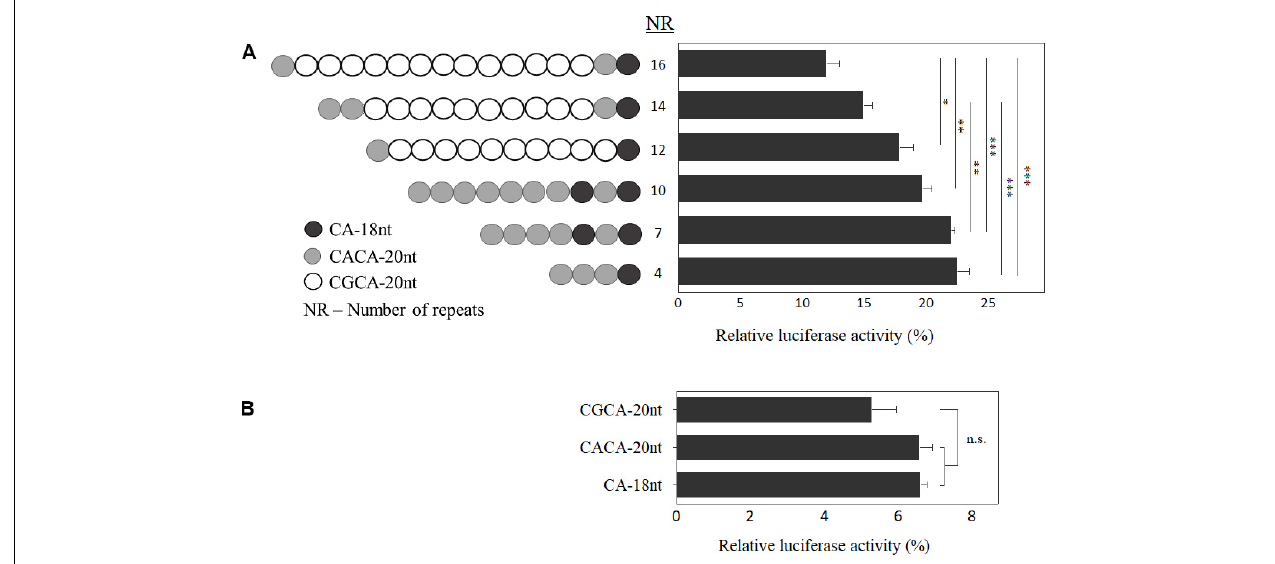
FIGURE 3 | Functional analysis of EIF4A3 5 (cid:48) UTR motifs. Graph depicting the relative luciferase activity, in percentage, of the constructs carrying different number of motifs (A) and of each motif independently (B) . Data are represented as mean ± SEM of five experiments, which were performed in triplicate. Relative luciferase activity = [(experimental sample ratio) – (negative control ratio)/(positive control ratio) – (negative control ratio)]. ∗∗∗ p < 0.001, ∗∗ p < 0.01, ∗ p < 0.05 and ns, non-significant; one-way ANOVA with Tukey post hoc tests.